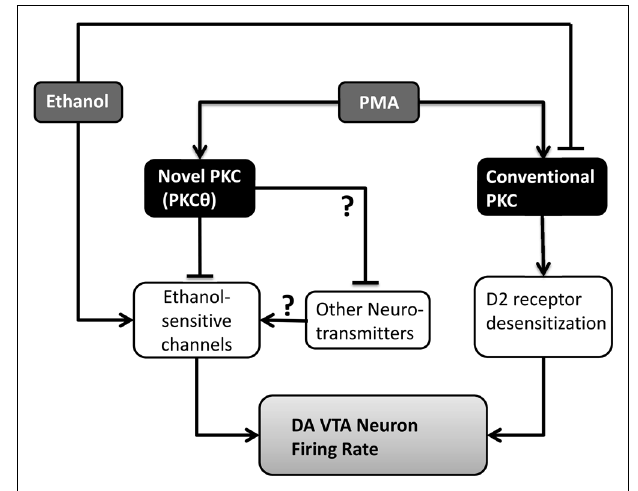
FIGURE 7 | Model of the interactions of PMA and ethanol in theVTA. PMA activates two isoforms of PKC: PKC θ and a conventional PKC responsible for D2 receptor desensitization. Ethanol inhibits the conventional PKC, and affects a number of ion channels (ethanol-sensitive channels) increasing the firing rate of DAVTA neurons. PKC θ interferes with the action of ethanol on ion channels in the DAVTA neuronal membrane, preventing the excitation. Unknown is whether other neurotransmitters interact with those same ethanol-sensitive ion channels and whether PKC θ alters those neurotransmitters as